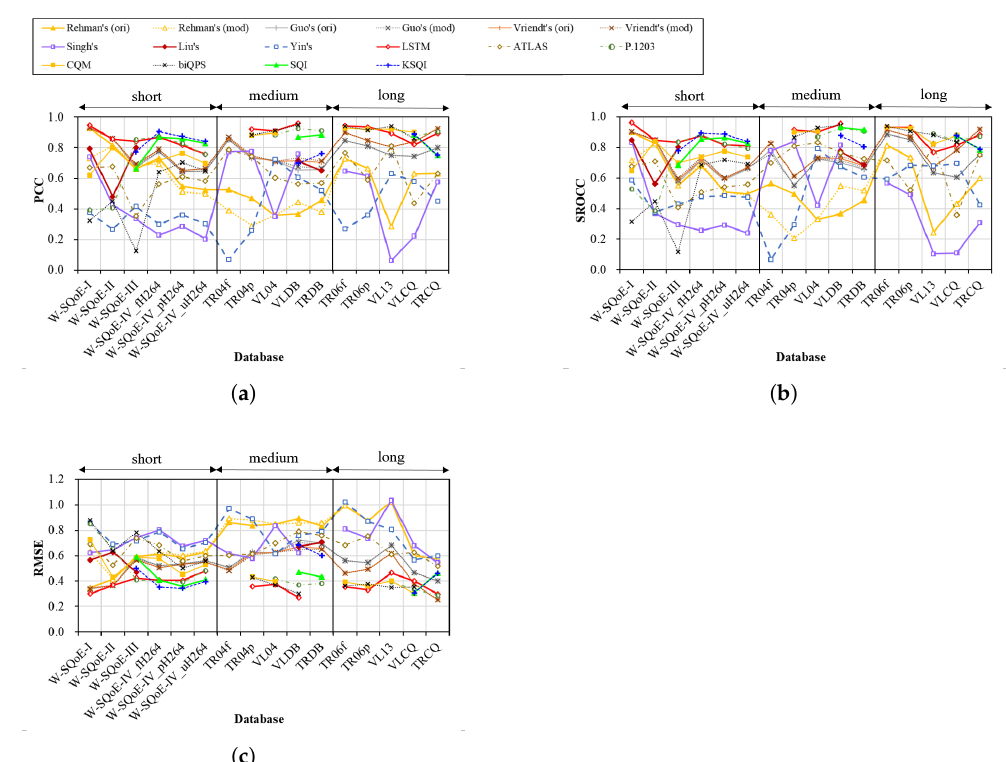
Figure 4. Performance of all the models with respect to different session durations. ( a ) PCC;